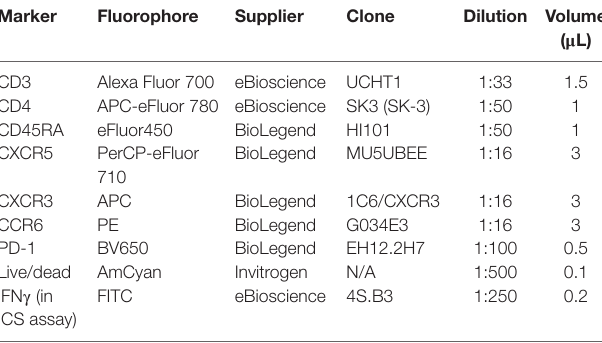
TaBle 2 | Circulating T follicular helper cell phenotyping panel.